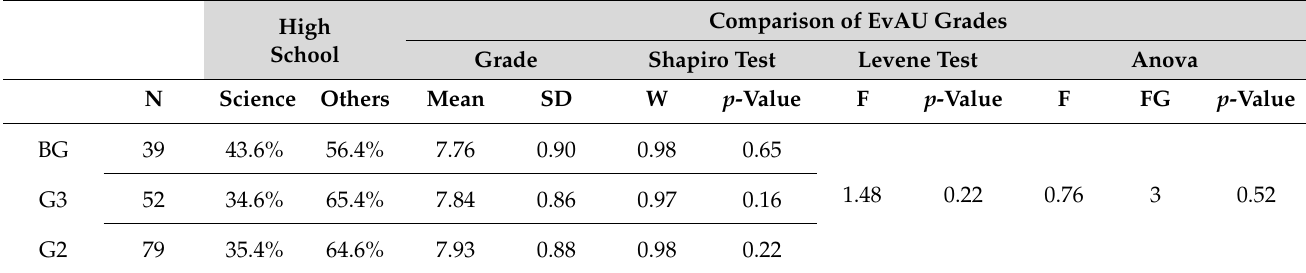
Table 2. Comparison of EvAU scores for the three groups considered. Comparison of EvAU GradesHigh